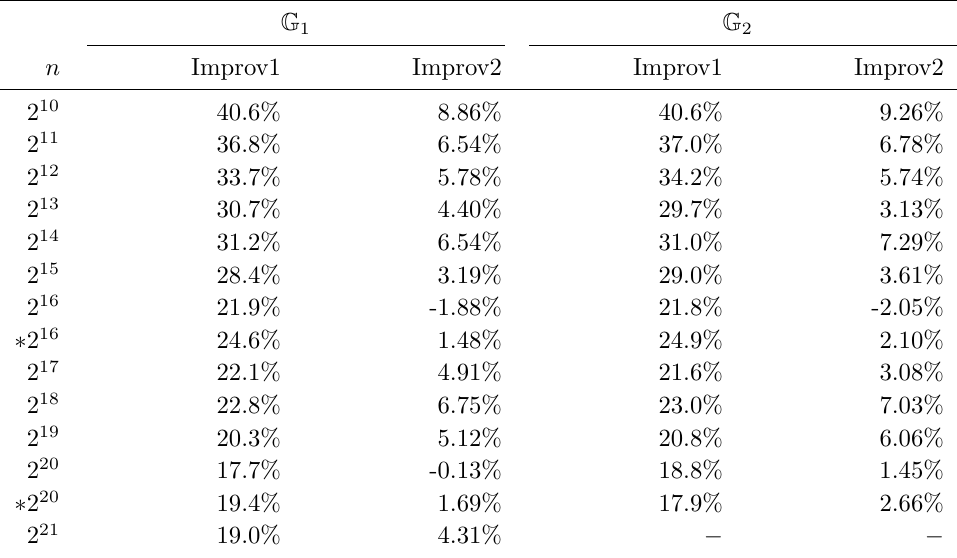
Table 5: Our method versus Pippenger’s bucket method and Pippenger’s